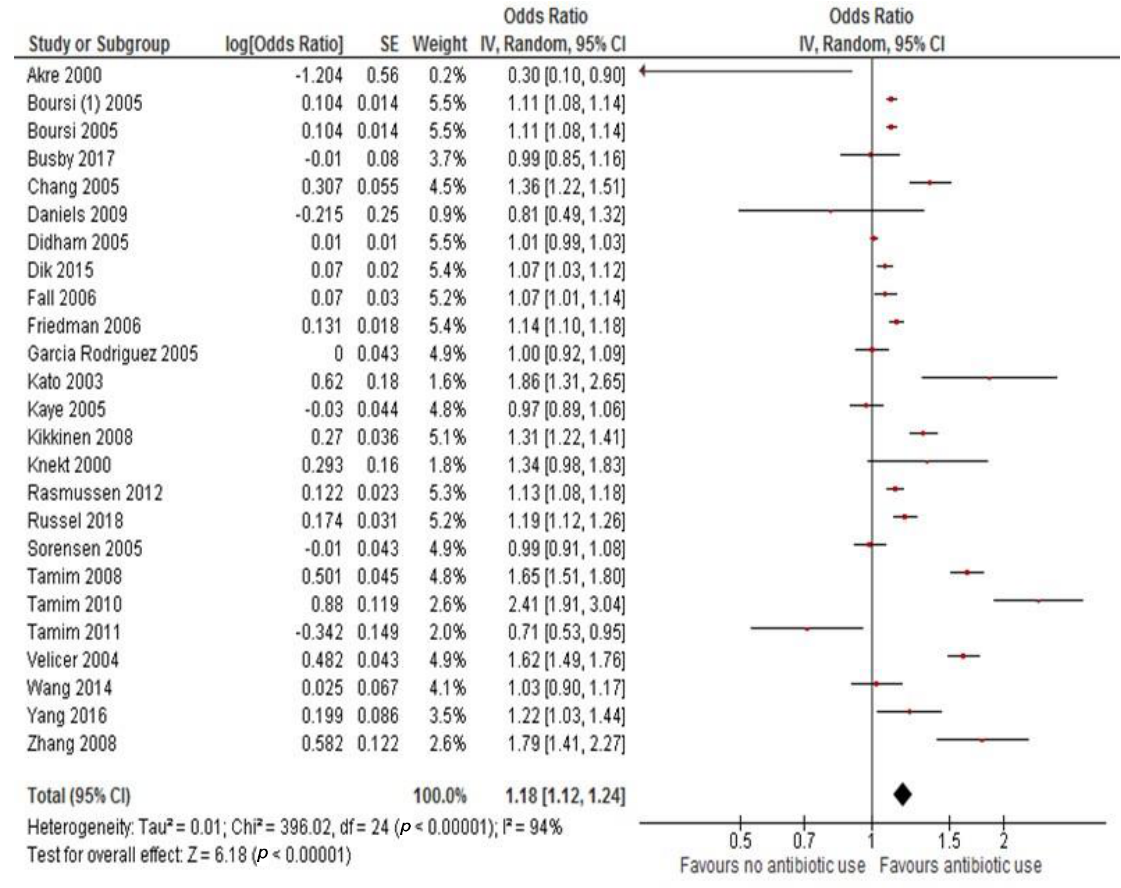
Figure 2. Odds ratio for cancer risk associated with antibiotic use.